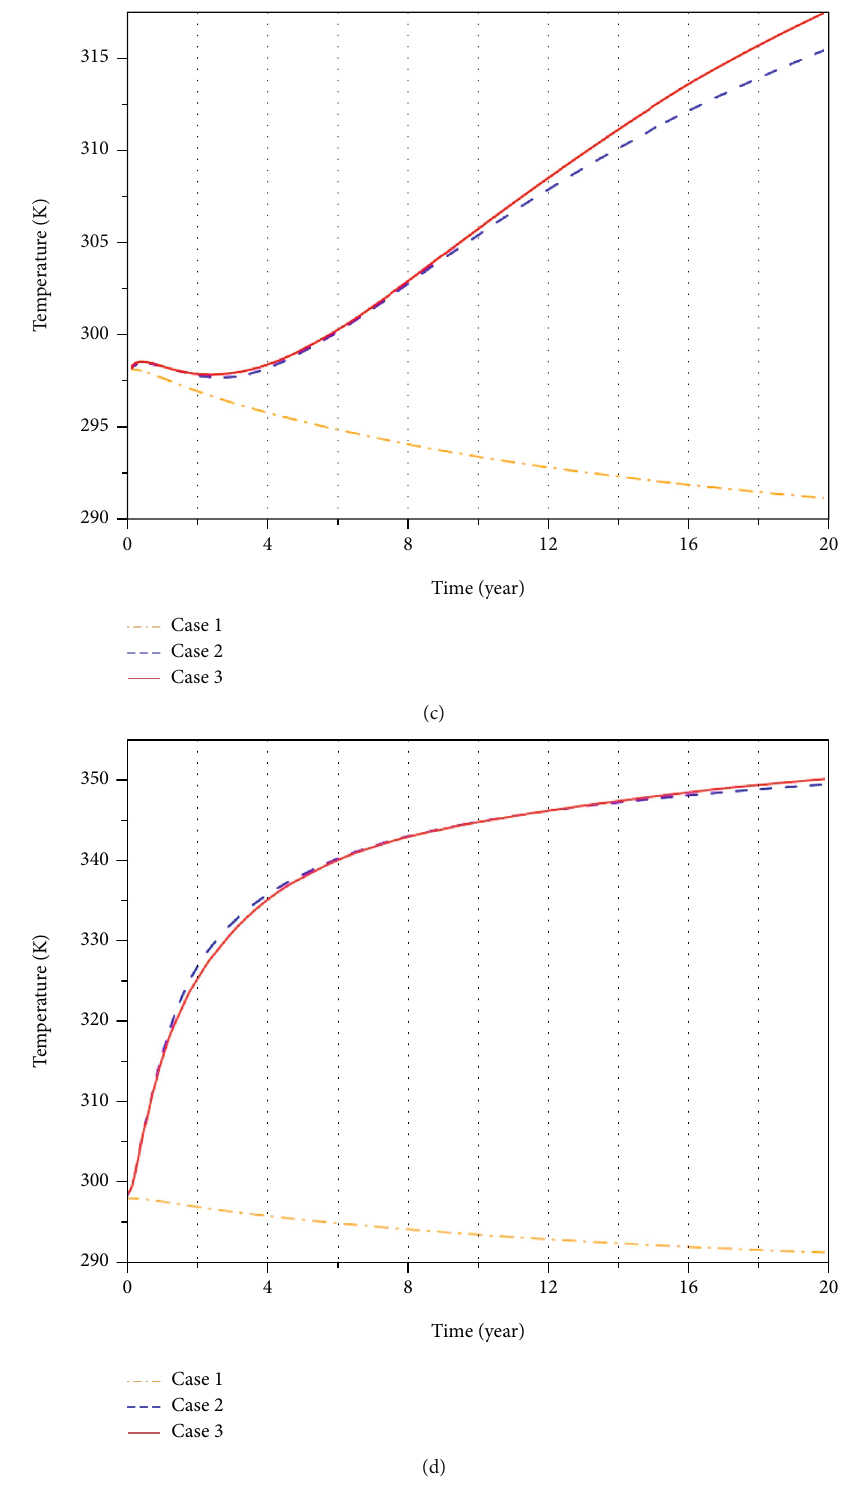
Figure 10: The temporal evolution of temperature for three di ff erent cases at (a) MP1, (b) MP2, (c) MP3, and (d)